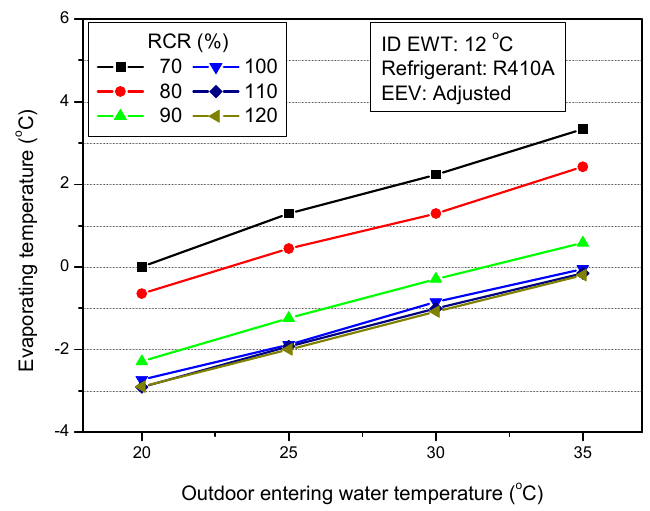
Figure 10. Variation of evaporating temperature with T OD in cooling mode.